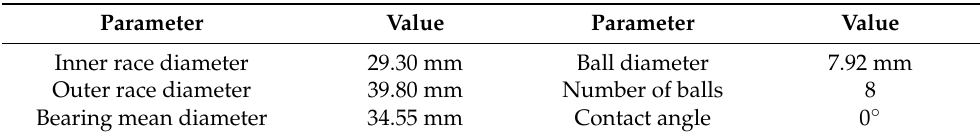
Table 3. LDK UER204 bearing parameters.